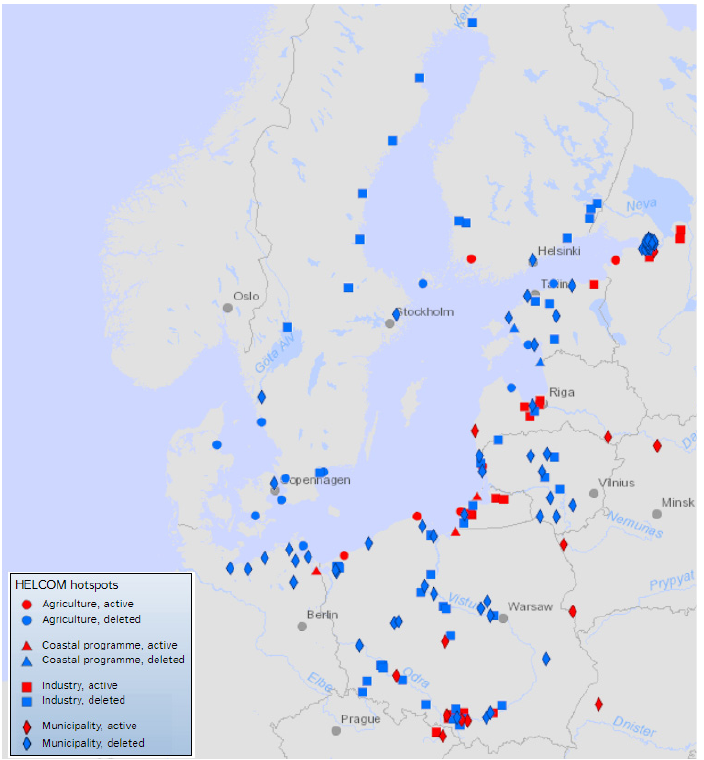
Figure 3. The Baltic Sea hot spots, based on HELCOM Map and Data Service [5].